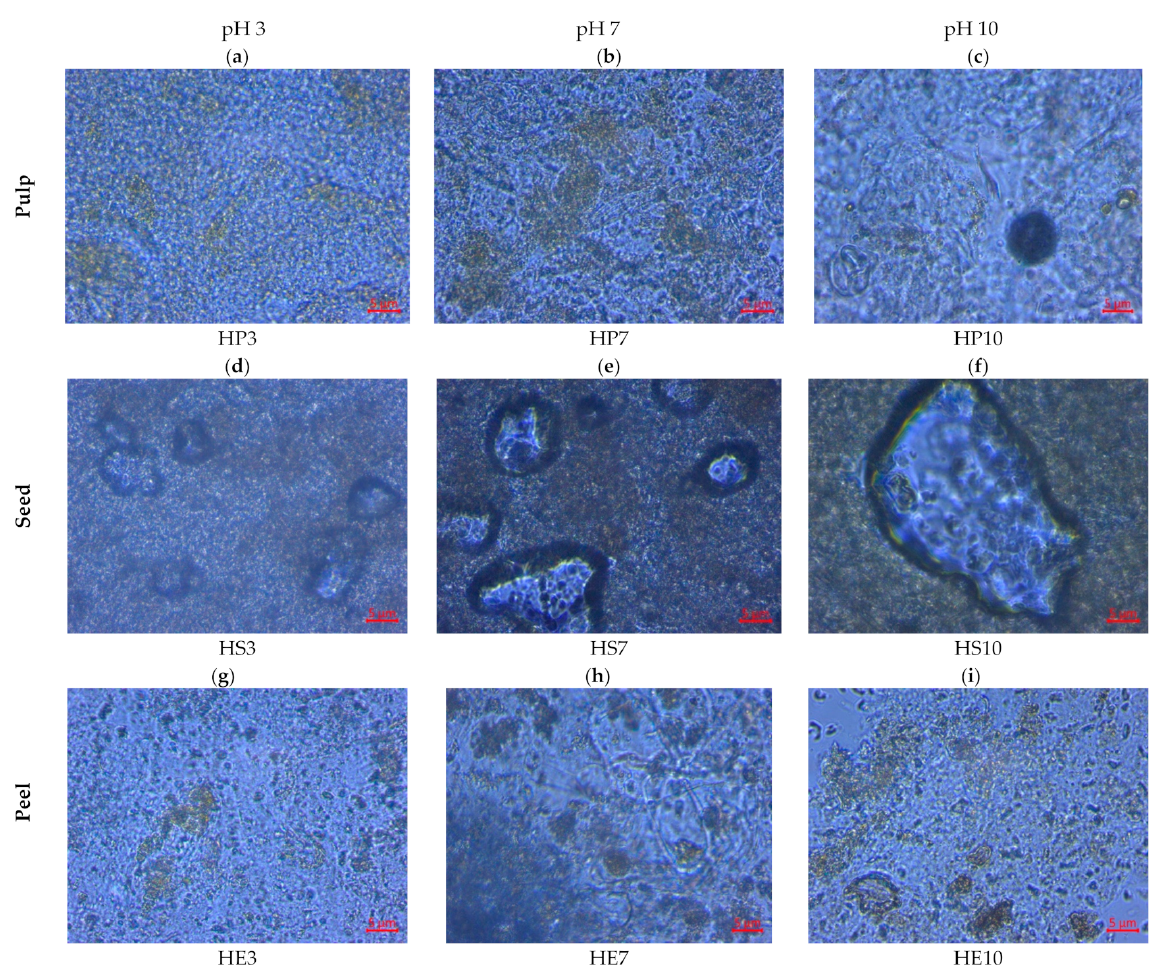
Figure 5. Microstructure of hydrocolloids from pulp, seed, and peel of mango ( Mangifera indica ) var.